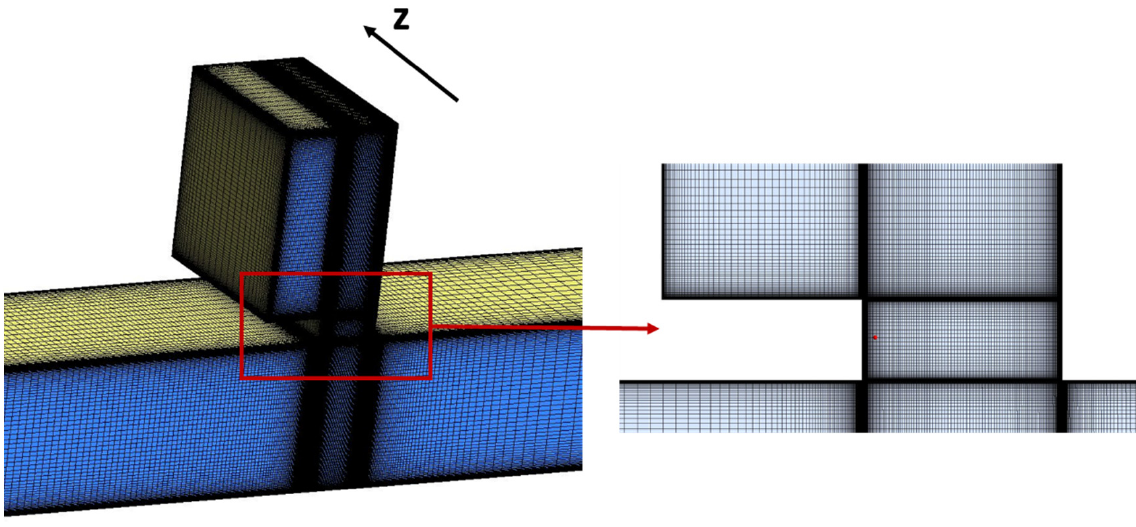
Figure 6. Applied computational mesh.